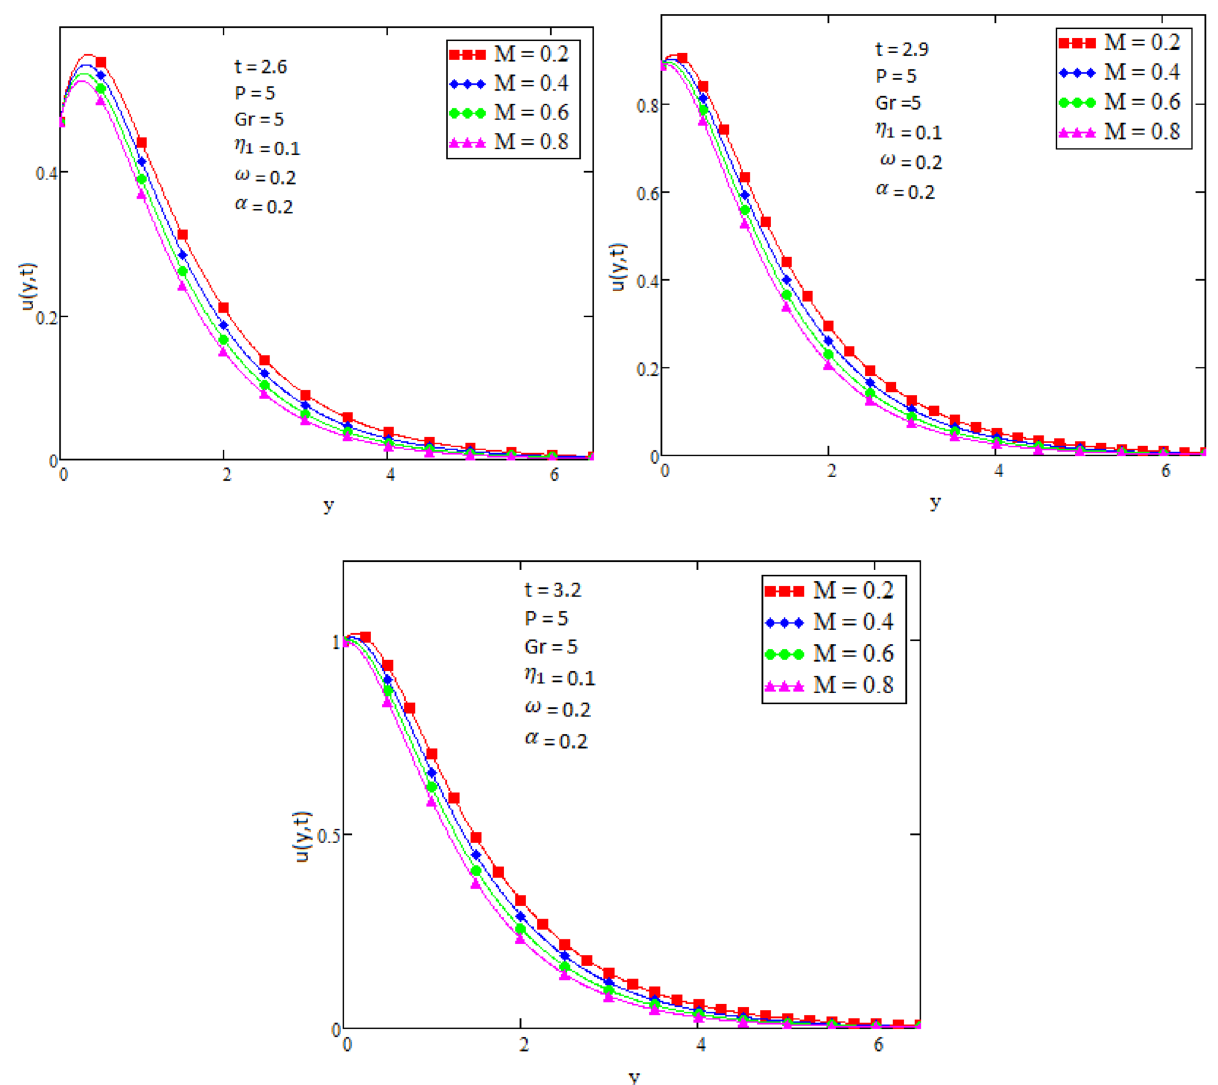
Figure 8. Velocity profile for different values of MHD.